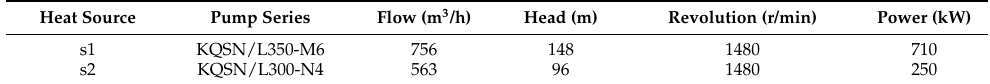
Table 2. Performance parameters of circulating